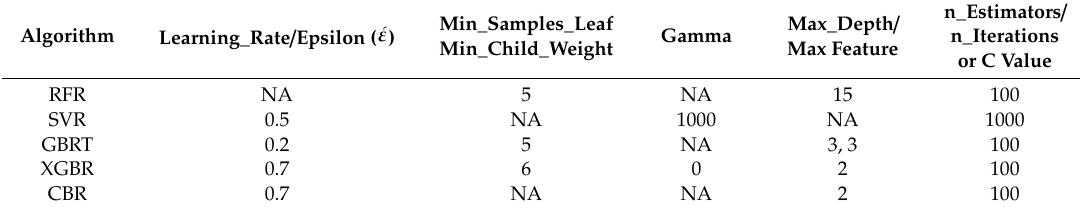
Table 4. Prior hyperparameter tuning using a grid search with a 5-fold CV for the di ff erent ML techniques.